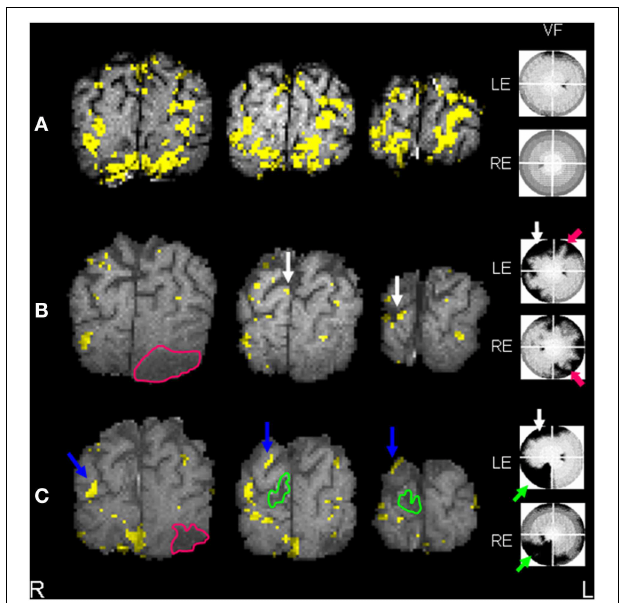
FIGURE 2 | (A) Control subject t -test SCRF maps (individual exemplar) overlaid onto corresponding T1-weighted images, 3 coronal slices through occipital pole and calcarine cortices, demonstrating symmetrical activation in striate (calcarine) and extrastriate regions. Normal visual field in seen on perimetry, right of figure. (B) Patient t -test SCRF maps overlaid onto corresponding T1-weighted images, 3 coronal slices through occipital pole and calcarine cortices (radiological convention), demonstrating reduced extrastriate activation and bilaterally absent calcarine activation, common acutely secondary to diaschisis. Stroke site traced in pink. Corresponding visual deficit again shown, highlighted with pink arrow. Note the white arrows highlighting sites of activation in the middle occipital lobe. (C) Patient t -test SCRF maps overlaid onto corresponding T1-weighted images, 3 coronal slices through occipital pole and calcarine cortices (radiological convention), demonstrating bilateral return of striate (calcarine) activation, despite the presence of a further stroke, stroke site traced in green. Corresponding visual deficit shown, green arrow. Note that the new stroke site has affected an area of activation demonstrated in the initial fMRI, but visual cortical reorganization has continued despite the recurrent lesion. Blue arrows point out regions of activation not present on initial